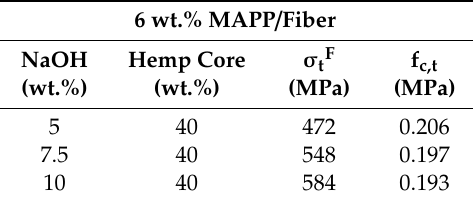
Table 4. Intrinsic tensile strength and tensile coupling factor of hemp core fibers